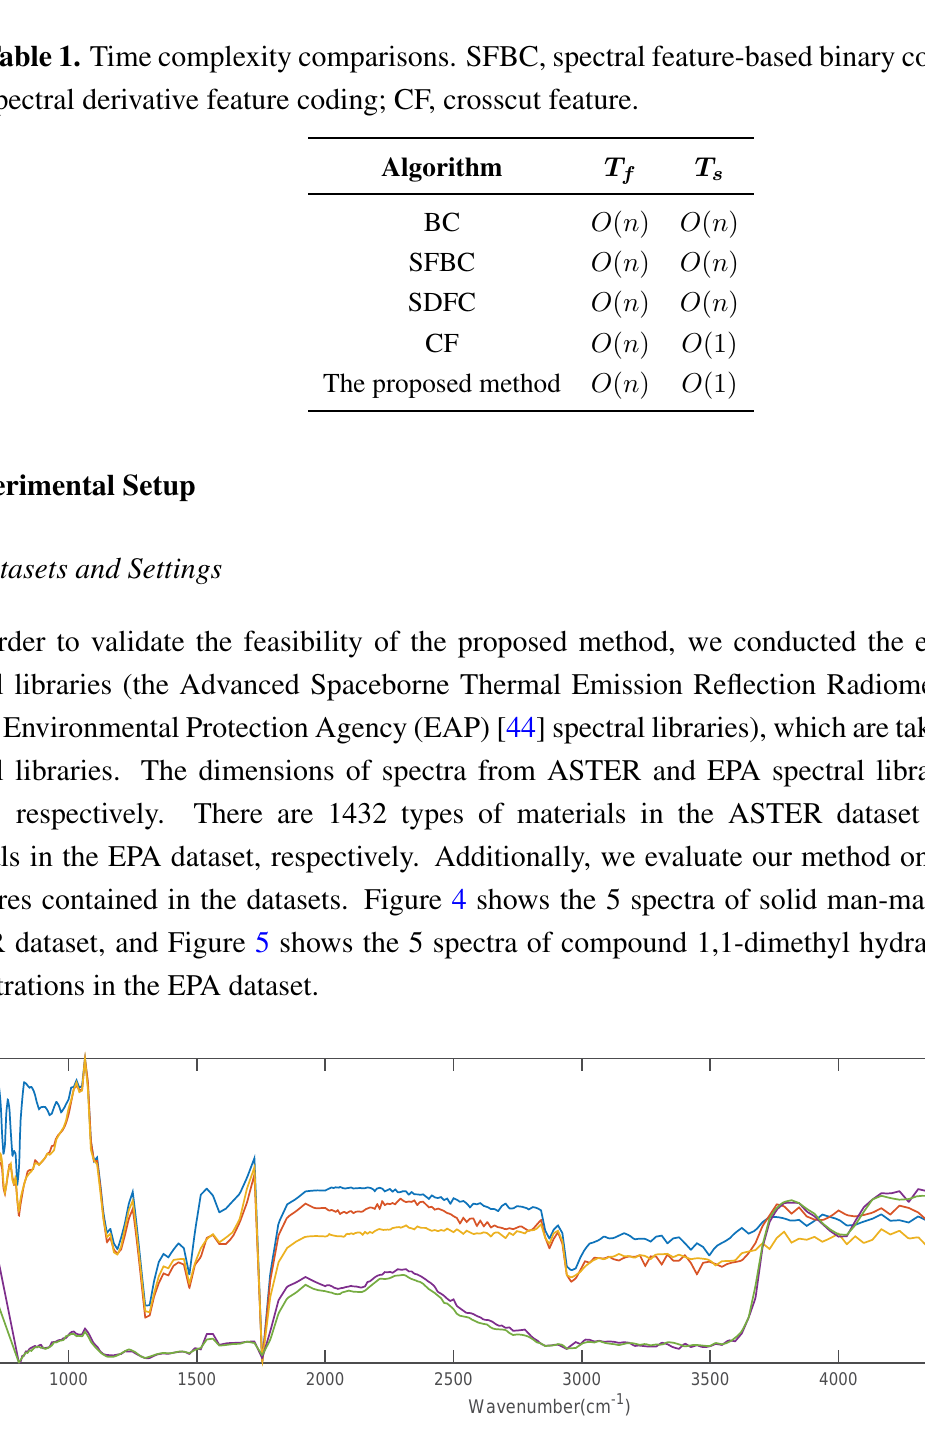
Figure 4. Five spectra of solid man-made materials in the ASTER